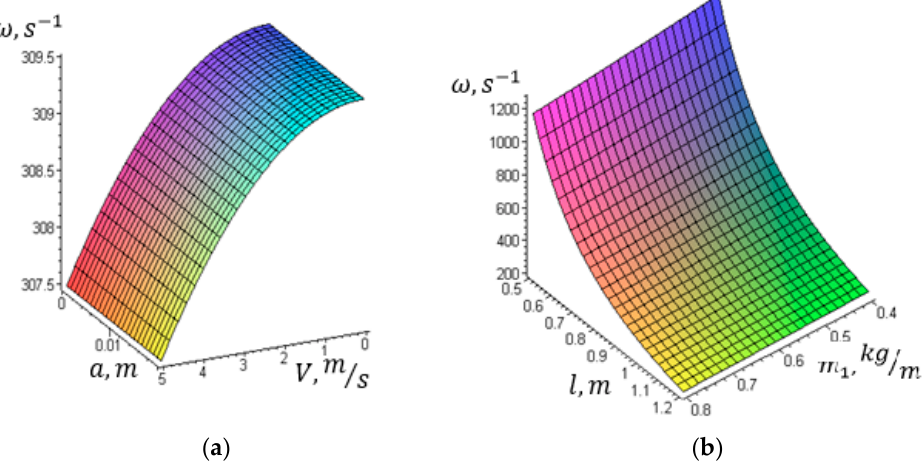
Figure 1. ( a ) Relation of the frequency of nonlinear bending vibrations of the elastic body on the amplitude a and continuous flow V of homogeneous medium (CFHM) relative speed V and ( b ) the length of the elastic body and CFHM bulk mass at a constant relative speed of the latter.